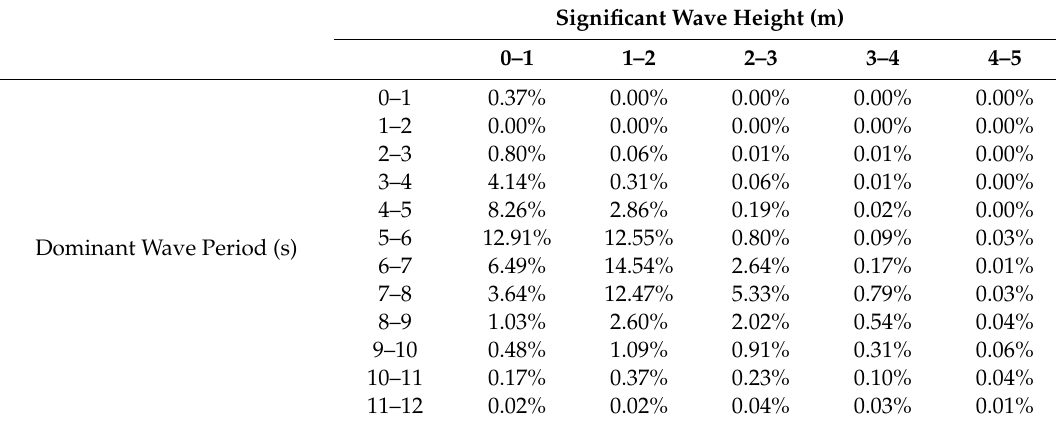
Table 2. Annual energy resource potential (kWh/m ∙ y) based on hourly resolution data.